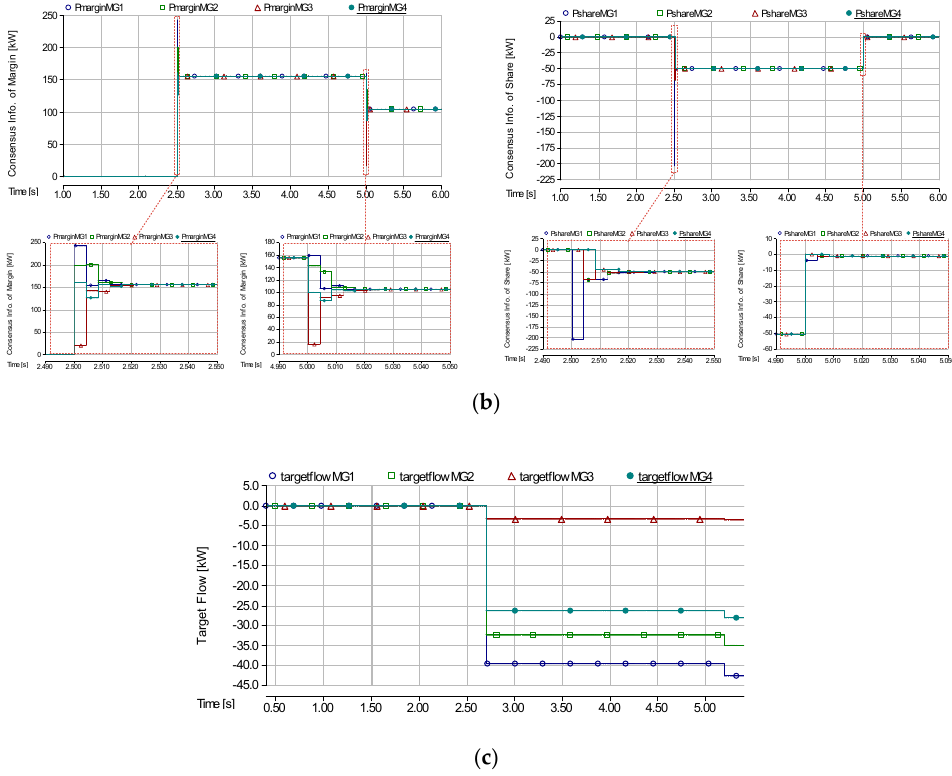
Figure 8. Simulation result in the MMG level (Case 2). ( a ) Power of the MMG flow, the MMG BESS, the MGs and load; ( b ) Convergence of the power margin and sharing power of the MGs; ( c ) Target flow of each MG PCC.